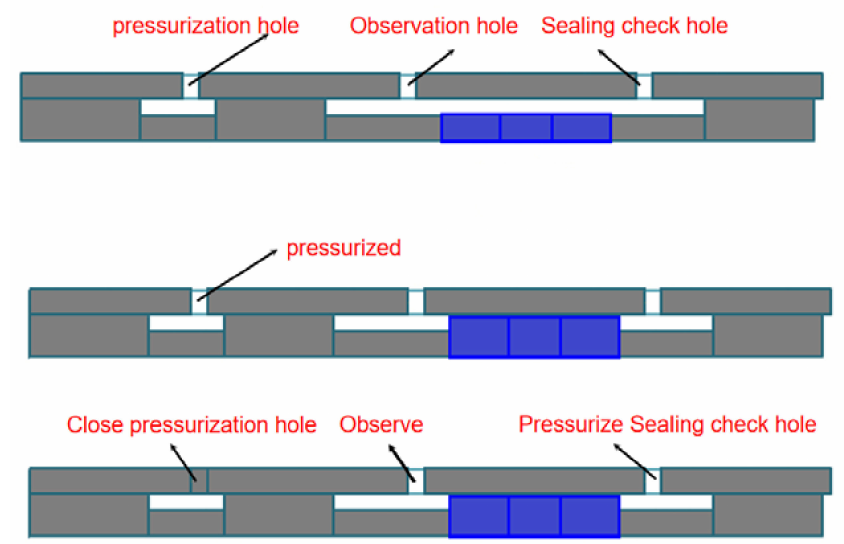
Figure 14. Experimental schematic